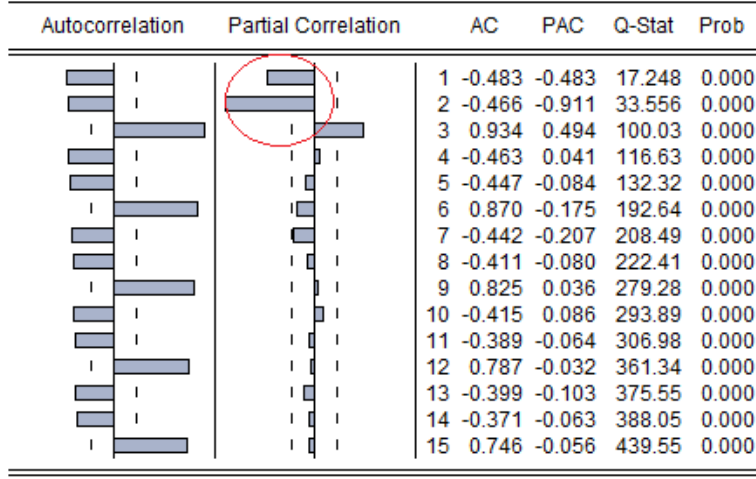
Figure 6 . The ACF and PACF of electricity load sequences for the large sample Figure 6. The ACF and PACF of electricity load sequences for the large